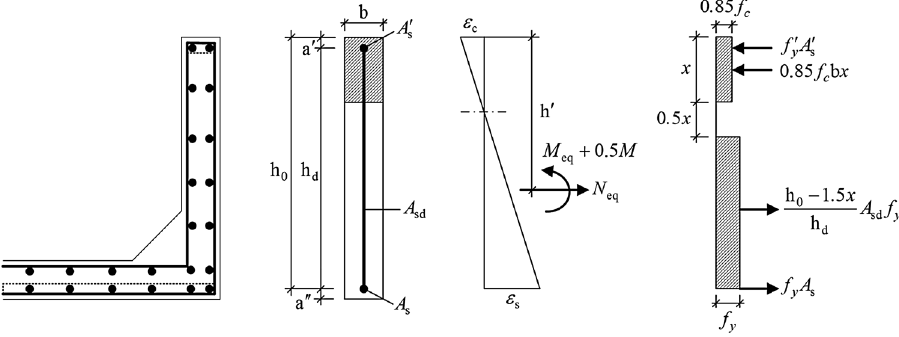
Fig. 14 Stress condition of the loaded half U-section at the ultimate